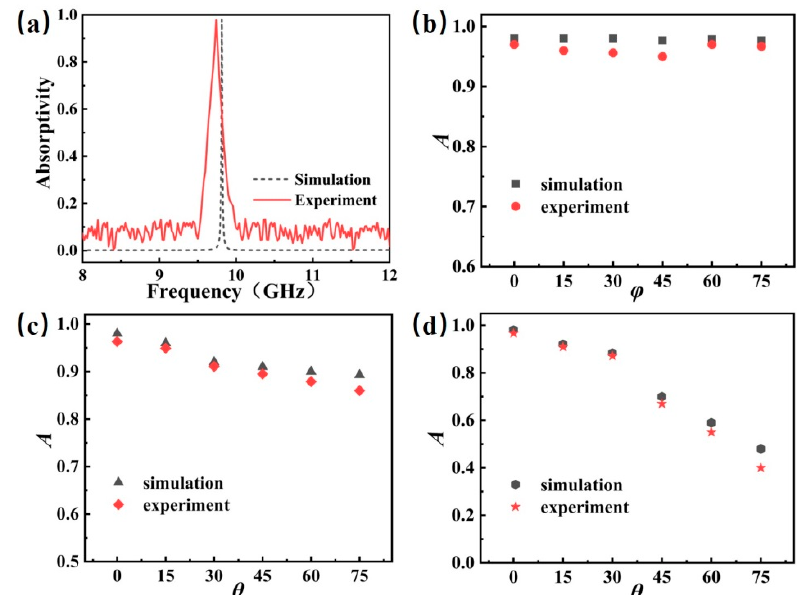
Figure 3. Simulation and experimental results of EMW absorption performance of the designed absorbing concrete: ( a ) the simulation and experimental absorption spectra; ( b ) absorption with different φ at 9.82 GHz; ( c ) absorptivity with different θ for TE mode at 9.82 GHz; and ( d ) absorptivity with different θ of for TM mode at 9.82 GHz.